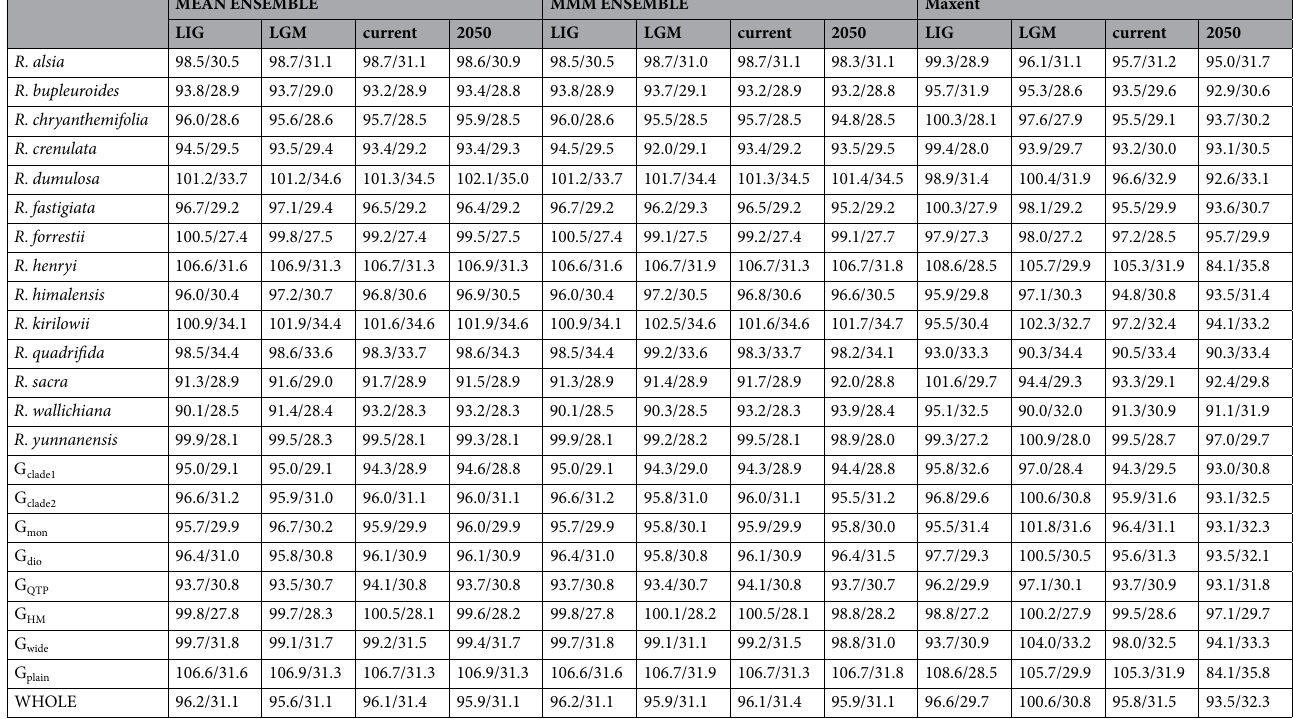
Table 4. Mean longitude/latitude (degree) of Rhodiola species and species groups for each time period using MEAN ENSEMBLE, MMM ENSEMBLE and